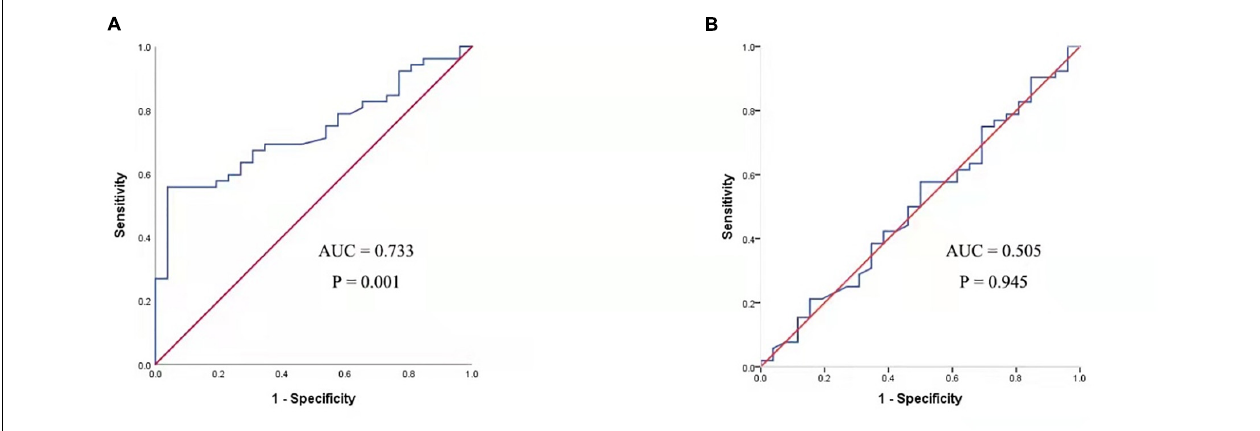
FIGURE 6 | ROC analysis of serum CXCL13 level (A) and BAFF level (B) in predicting the clinical outcome of SCIT in a validation cohort. CXCL13, C-X-C motif ligand 13; SCIT, subcutaneous immunotherapy; ROC, receiver operating characteristics; AUC, area under the curve; AR, allergic rhinitis; BAFF, B cell-activating factor.